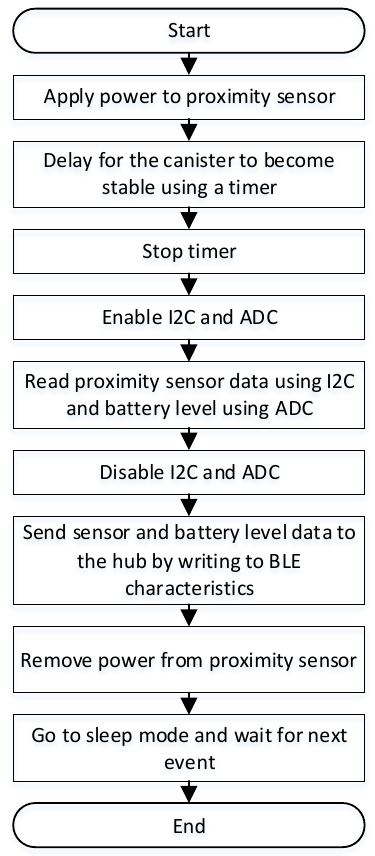
Figure 3. Flowchart of actions after the cap is put on the canister.